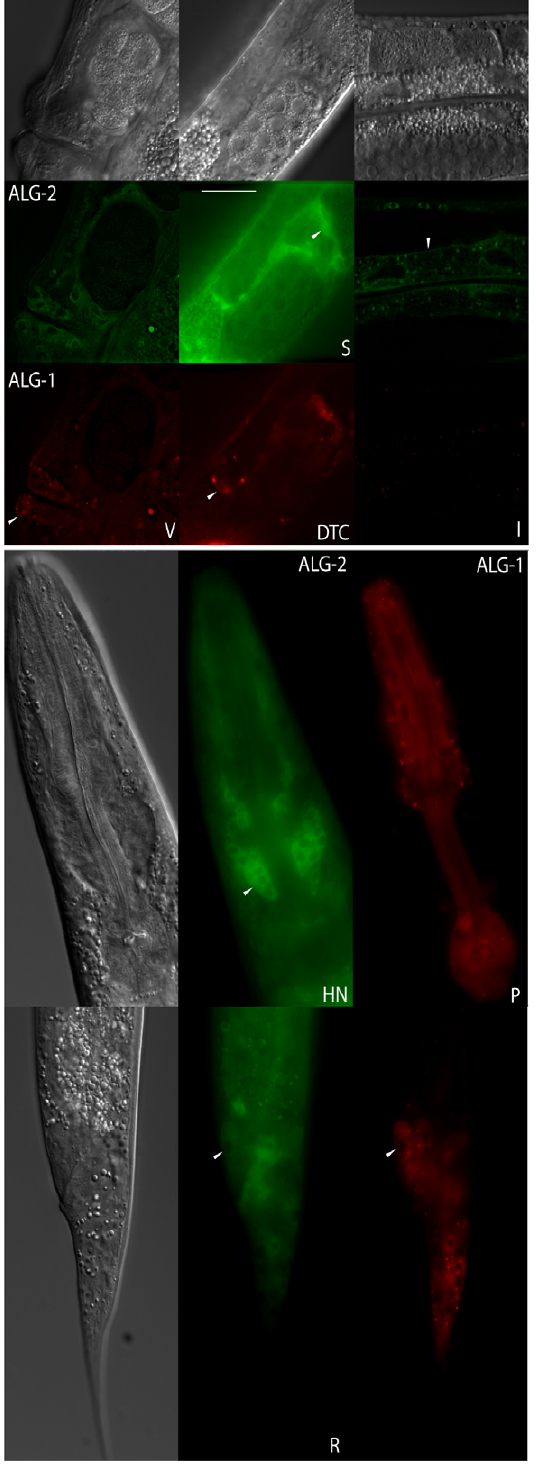
Figure 2. ALG-1 and ALG-2 expression profile in adult worms. Top panel: GFP::ALG-2 and RFP::ALG-1 are co-expressed in most tissues including vulva (V) and spermatheca (S). Bottom panel: Predominant GFP::ALG-2 expression is seen in a set of head neurons (HN) and tail cells (T) while RFP::ALG-1 is strongly expressed in the pharynx (P) and some tail cells (T). Scale bar 20 m m. doi:10.1371/journal.pone.0033750.g002 PLoS ONE |